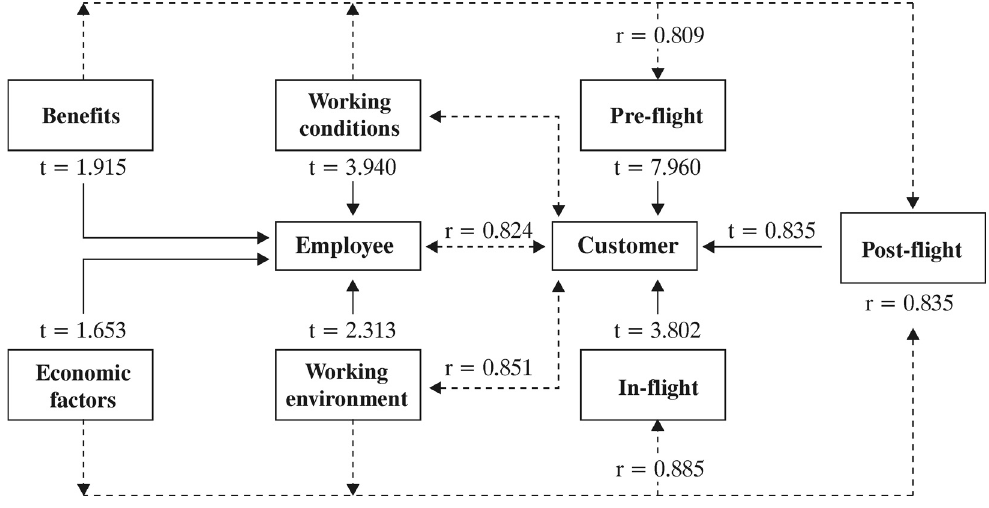
Model for the relationships between employee satisfaction and customer satisfaction variables